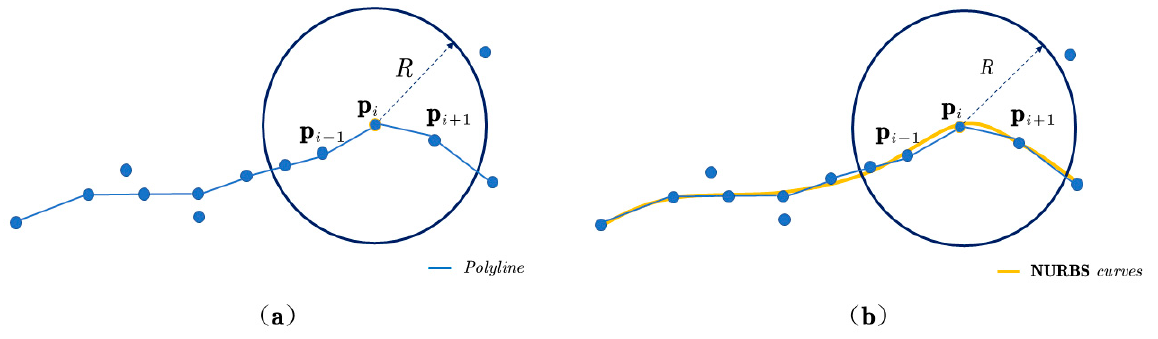
Figure 9. ( a ) The blue line is a step-feature line without smoothing, ( b ) the yellow curve is a step- feature line optimized by NURBS.